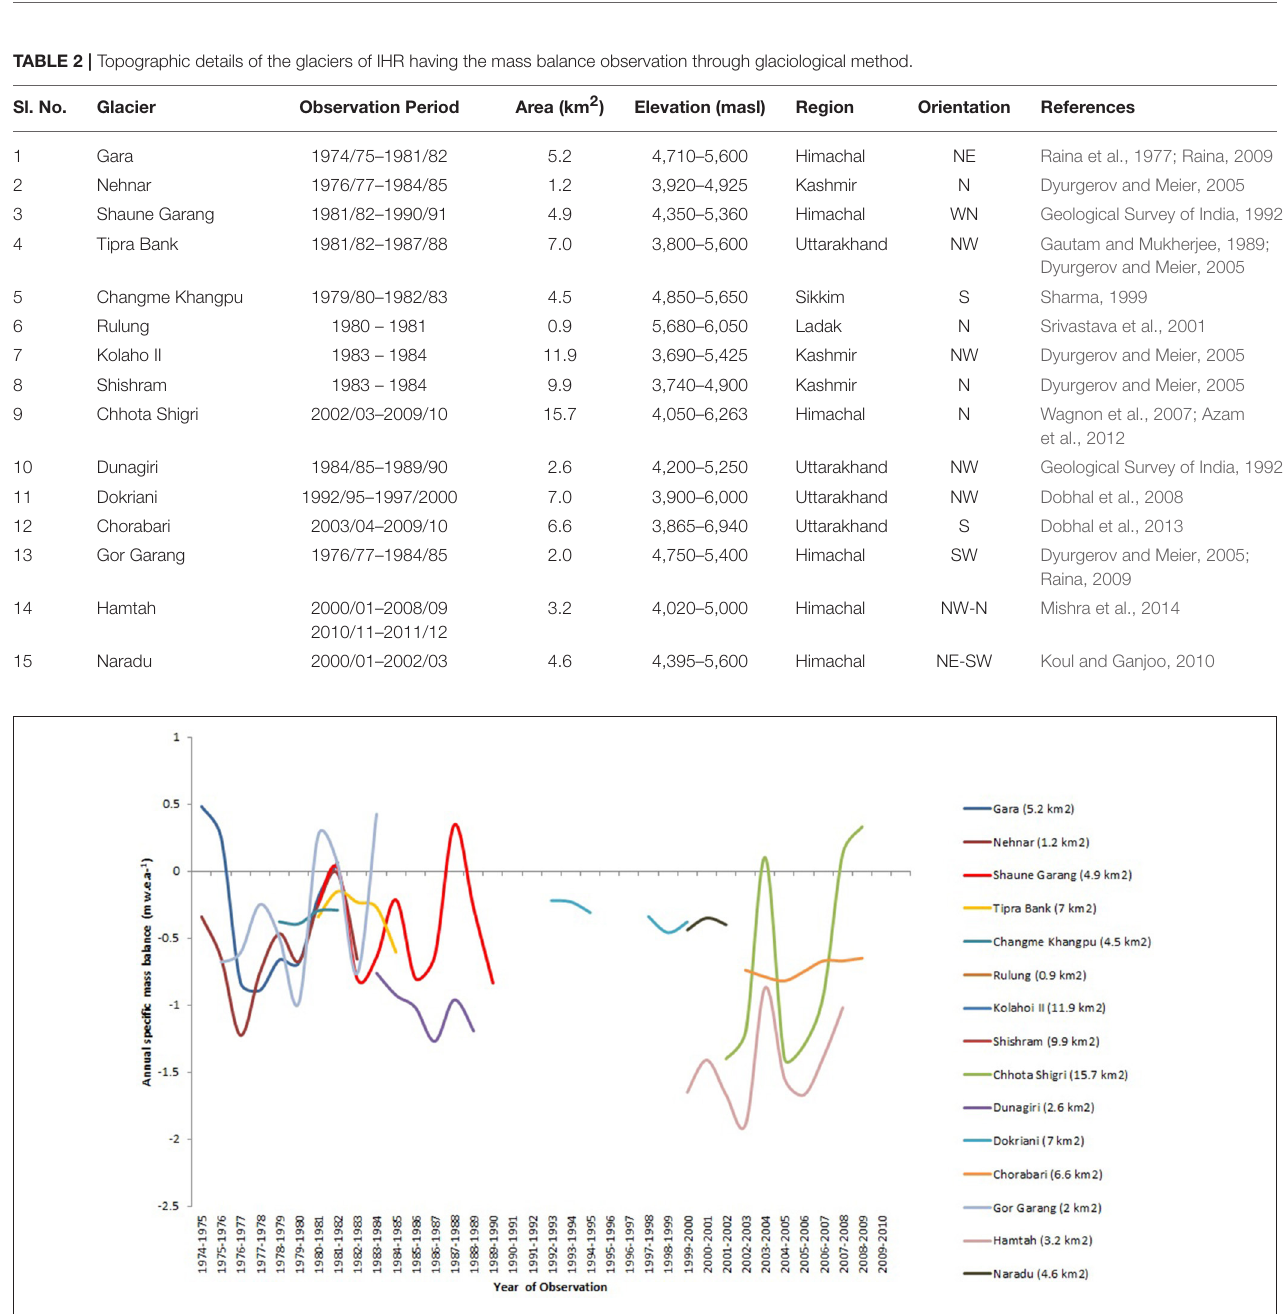
FIGURE 1 | Annual specific glacier mass balance available in Indian Himalayan